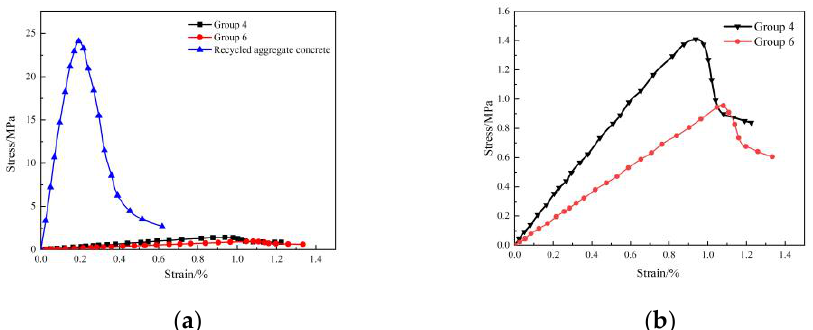
Figure 9. The stress – strain curve of lightweight CLSM. ( a ) Comparison of lightweight CLSM and recycled aggregate concrete; ( b ) the stress – strain curves of Groups 4 and 6.